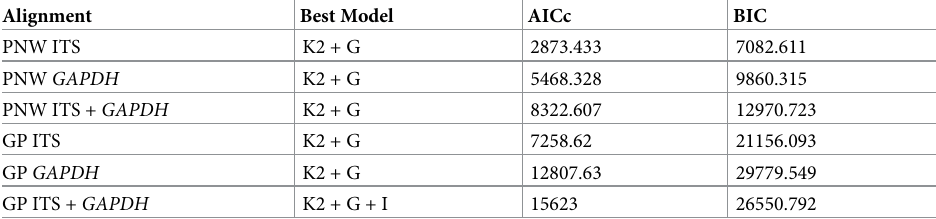
Table 1. Model with best fit analysis, Bayesian Information Criterion, and Akaike Information Criterion (AICc) for each alignment per an analysis using MEGA X software. Lower BIC and AICc values indicate the best model fit for use in